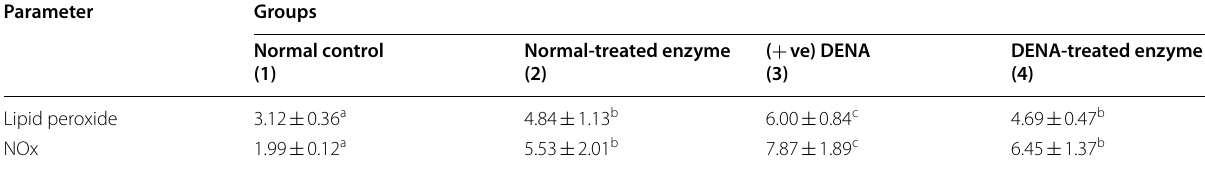
Data are expressed as means SD of six mice in each group ± Analysis of data is carried out by one‑way (ANOVA) (analysis of variance) accompanied by post hoc (LSD, least significant difference) (CoStat, computer program) Different letters indicate that these groups are significantly correlated at P > 0.05 Different letters are significantly different from each other while similar letters are not significantly different at P <